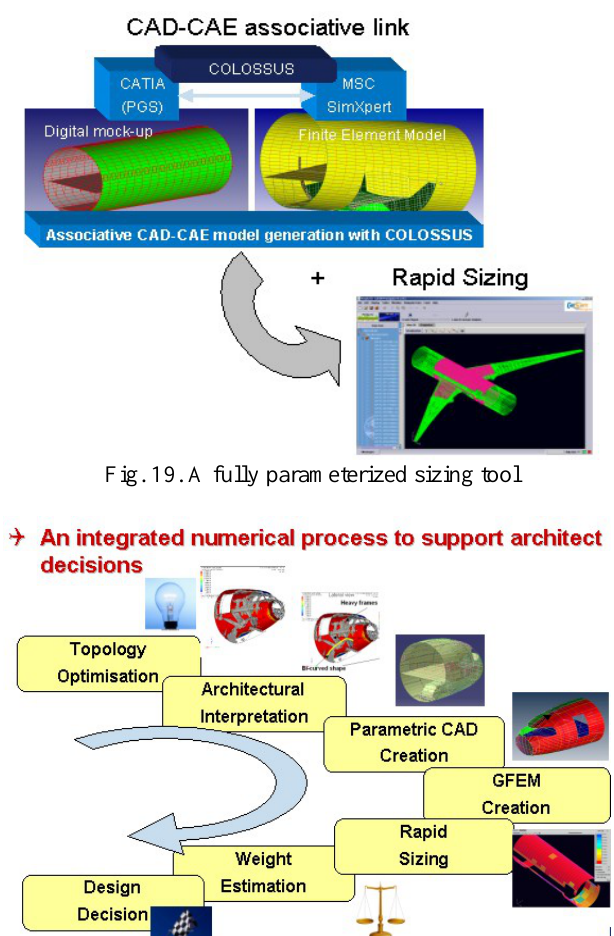
Fig. 20. From architecture creation to sizing and weight